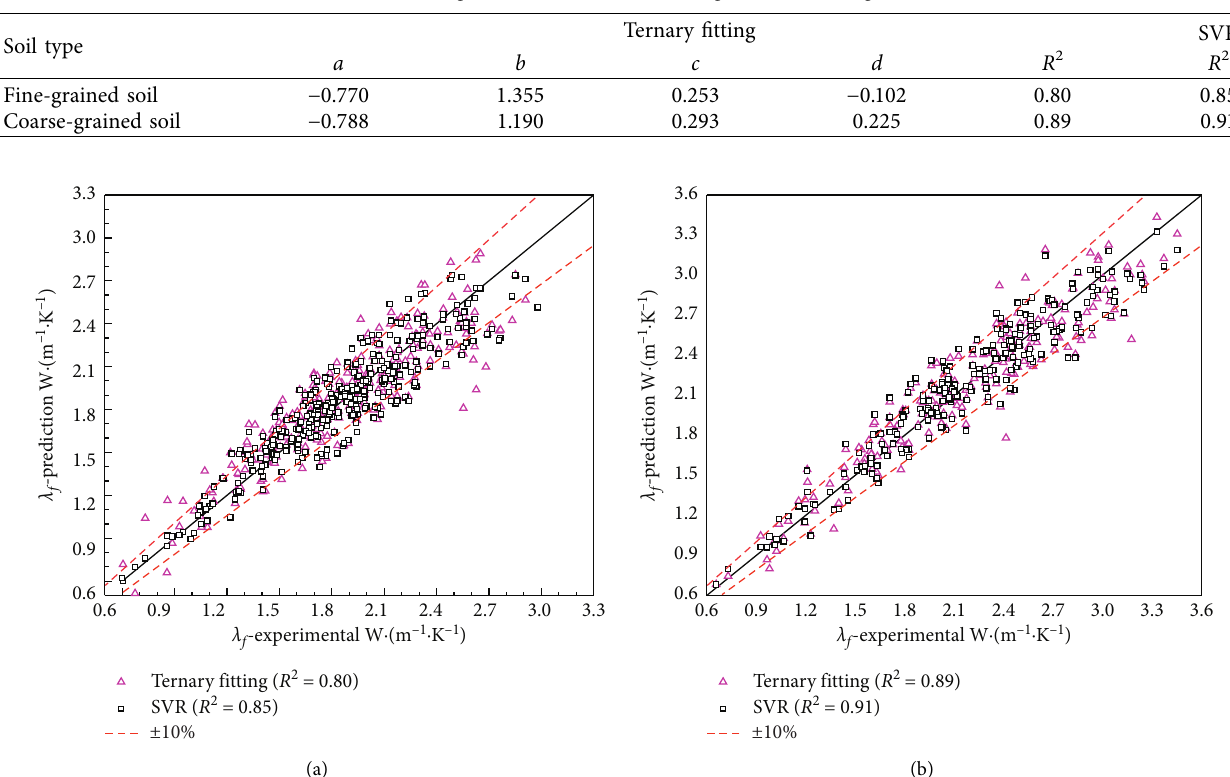
Table 5: Fitting results of coarse and fine-grained soil categories.